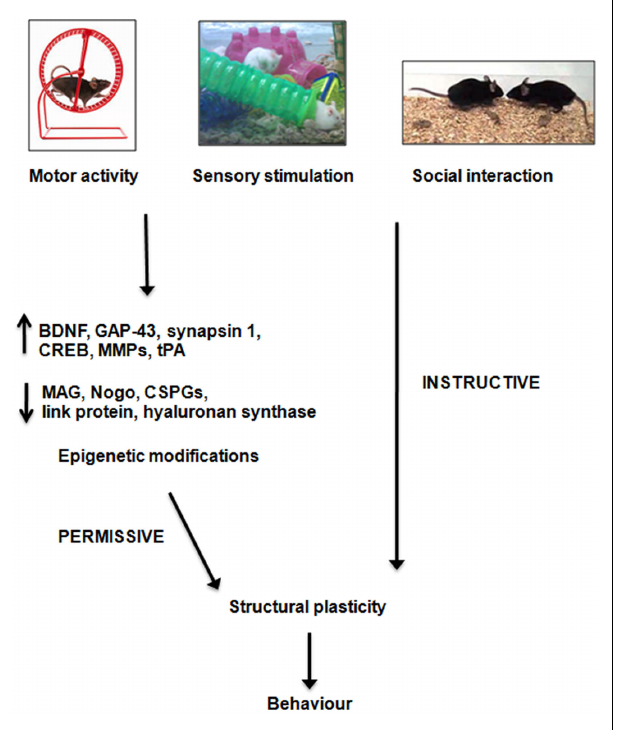
FIGURE 2 | Possible mechanisms of action of enriched stimulation on structural plasticity. Enriched stimuli, which can comprise increased motor activity, sensory stimulation or social interaction, modulate the expression of several growth-regulatory cues, and alter chromatin structure, so to create permissive conditions for neuronal plasticity and behavioral adaptation. In addition, external stimulation provides the involved neurons with instructive information, needed to shape connections patterns able to sustain adaptive functions. BDNF, brain-derived neurotrophic factor; GAP-43, growth-associated protein-43; MMP, matrix metalloproteinase; tPA, tissue plasminogen activator; MAG, myelin-associated glycoprotein; CSPG, chondroitin sulfate